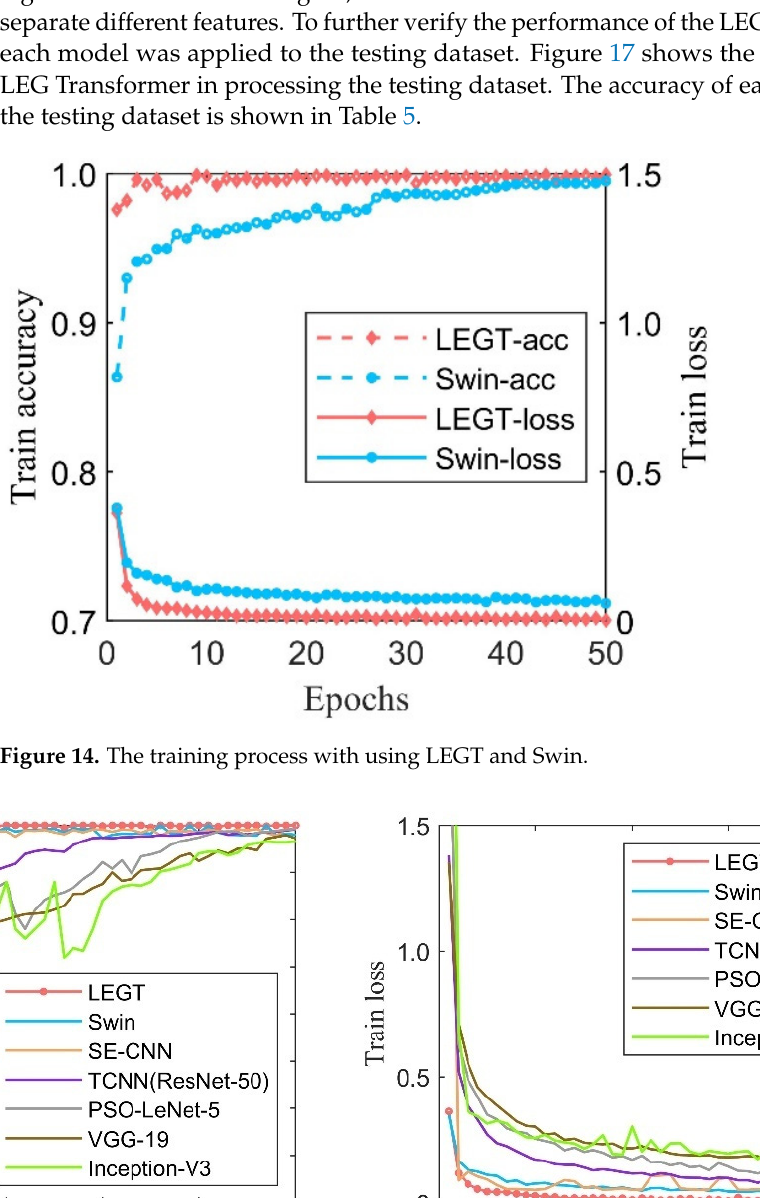
Figure 14. The training process with using LEGT and Swin.